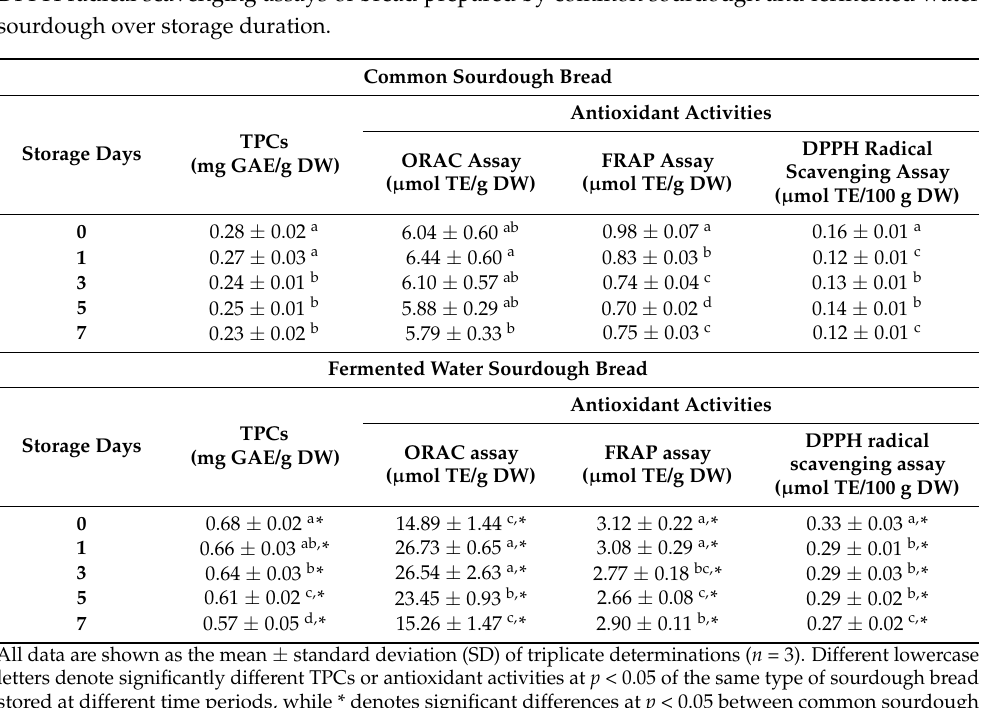
Table 5. Total phenolic contents (TPCs) and antioxidant activities detected by ORAC, FRAP, and DPPH radical scavenging assays of bread prepared by common sourdough and fermented